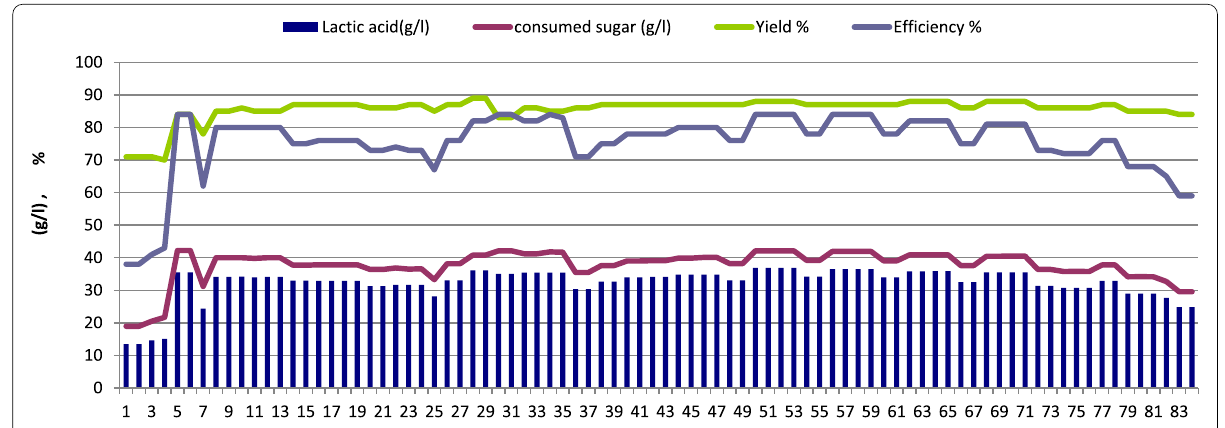
Fig. 6 Lactic acid production from salted cheese whey and whey permeate mixture (1:1, contained 5% sugar) using immobilized cells of Enterococcushirae